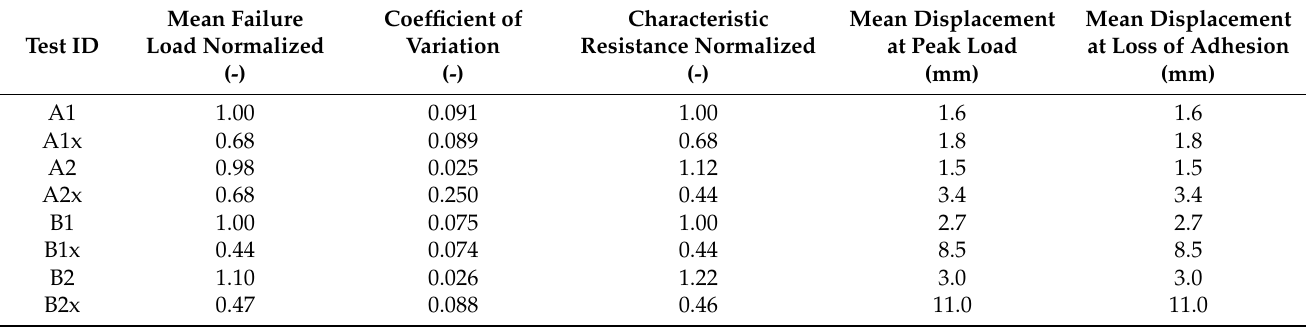
Figure 5. Typical pattern of failure in boreholes with correct preparation ( a ) and substandard cleaning ( b ), and ( c ) detail of failure at the mortar/steel thread interface under good bonding conditions in SFRC—Product A. Table 2. Overview of pull-out test results normalized by A1/B1 mean value as reference (standard installation in plain concrete).